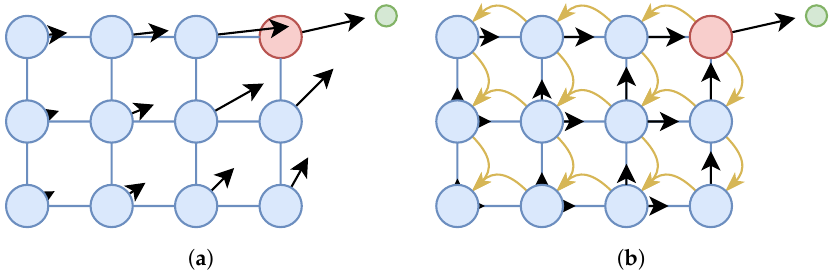
Figure 2. Illustration of the SOM and CSOM update mechanism, with BMU shown in red, new input in green, weight vectors represented as black arrows and update requests shown as yellow arrows. ( a ) SOM weight vectors update. ( b ) CSOM weight vectors